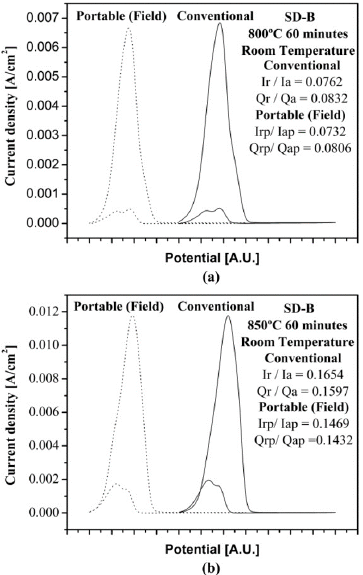
Figure 14. Comparison between DL-EPR cycles obtained in a conventional cell and in a portable cell for different aging time for SD-B: (a) 800 °C/60 min.; (b) 850 °C/60 min. 2.00 M H 0.01 M KSCN + 0.50 M NaCl solution test at room